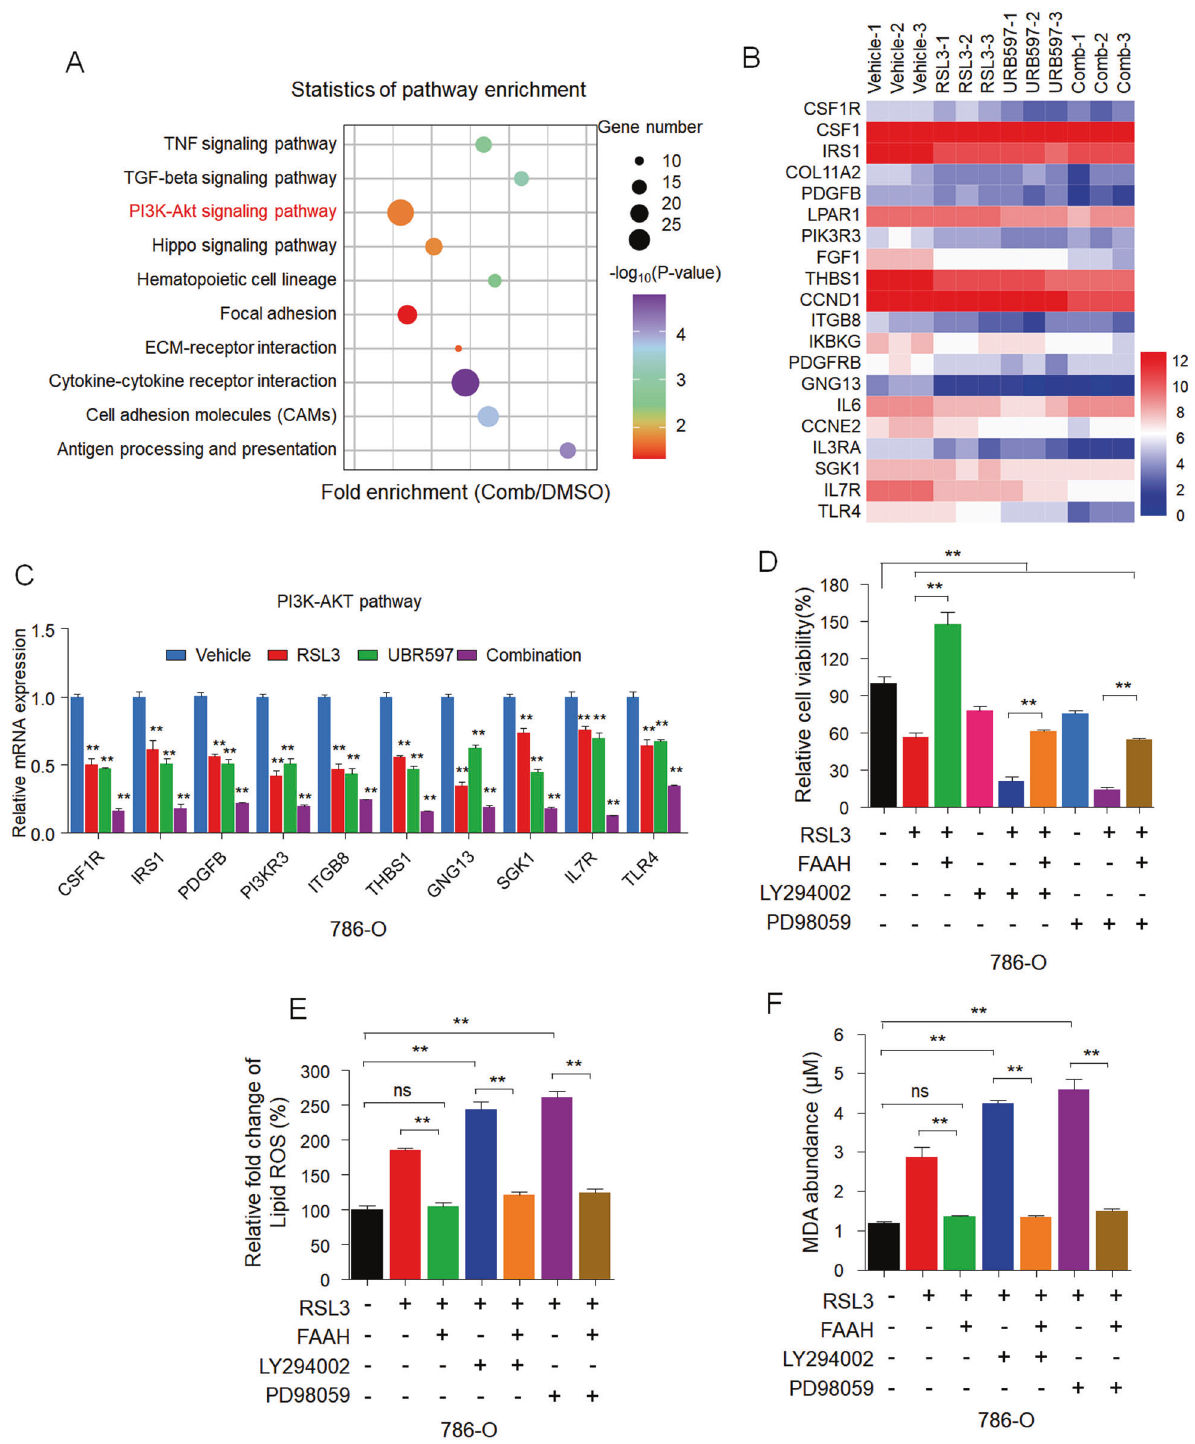
Fig. 6 RNA-Seq reveals inhibition of FAAH-regulated sensitivity to ferroptosis via the PI3K-AKT pathway. A KEGG pathway analysis of downregulated differentially expressed genes in transcriptomes of 786-O cells after combinational treatment (Comb) with URB597 (10 µM) and RSL3 (0.5 µM). The 10 most signi fi cantly activated pathways are shown. B Heat map of signi fi cantly regulated genes of transcriptomes of 786-O cells after combinational treatment with URB597 (10 µM) and RSL3 (0.5 µM) correlated with the PI3K-AKT pathway ( n = 3). C qPCR analysis of the indicated gene expression associated with the PI3K-AKT pathway in 786-O cells treated with URB597 (10 µM) and RSL3 (0.5 µM) singly or in combination for 48 h compared to parental 786-O cells. ** p < 0.01 versus the corresponding control ( t test). D The viability of 786-O cells stably transfected with empty vector or FAAH treated with RSL3 (0.5 µM), LY294002 (5 µM), or PD98059 (10 µM) singly or in combination. Cell viability was assessed by CCK-8 assay after treatment for 72 h with the indicated doses of drugs. Effect of FAAH overexpression, LY294002 (5 µM), and PD98059 (10 µM) on lipid peroxidation ( E ) and MDA ( F ) response to RSL3 treatment in 786-O cells. Data are means ± SDs of measurements repeated three times with similar results. ns (not signi fi cant), ** p < 0.01 (one-way